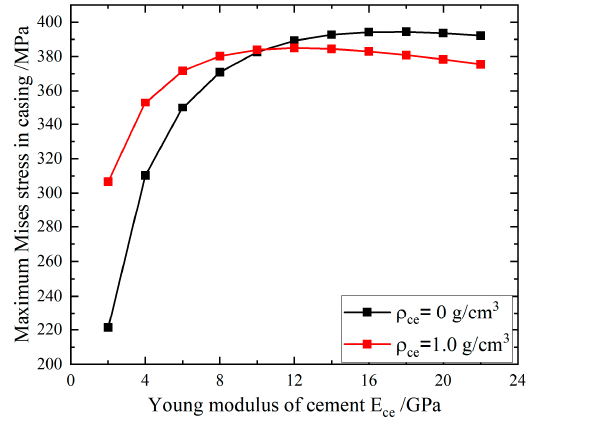
( b ) Figure 12. The initial stress state of cement’s e ff ect on the maximum von Mises stress in ( a ) casing and ( b ) cement in the present 3D model for the given speci fi c parameters in Table 1. 5. Conclusions This paper presents a new 3D analytical model for evaluating the stress fi eld in in- clined oil/gas wells, considering in-situ stress as the initial stress instead of boundary pres- sure loads and the existence of the initial stress of cement. The 3D analytical solution is obtained by dividing the model into an in-plane plane strain problem, elastic uni-axial stress problem and anti-plane shear problem. Moreover, the accuracy of the present model is validated by the existing model results and fi nite element analysis. The following main conclusions can be made: